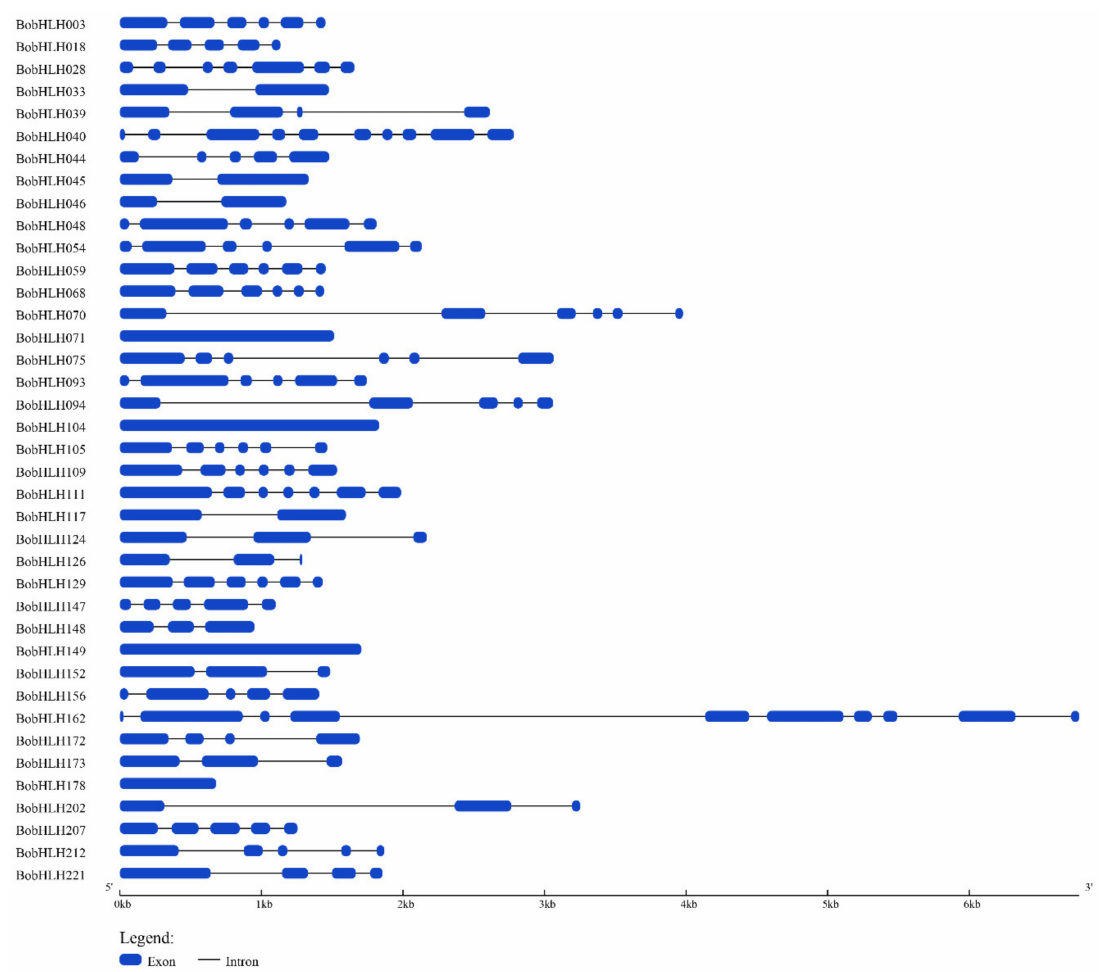
Figure 6. Gene structures of chilling-responsive BobHLH genes. The structures of BobHLH genes were plotted using blue boxes representing exons, black lines representing introns. The scale on the bottom is in the unit of kilobase (Kb). The gene structures in each BobHLH gene are in Figure